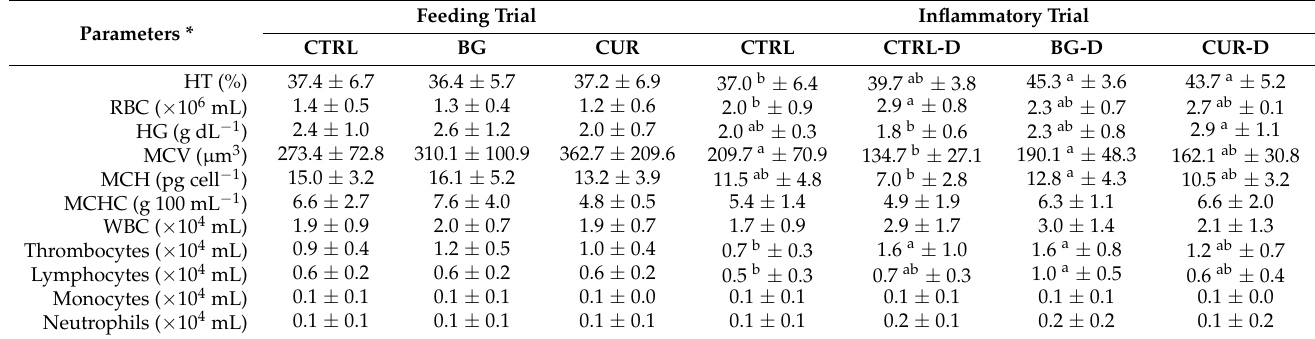
Table 3. Hematological profile of gilthead seabream after the feeding and inflammatory trials ( n = 12). CTRL (control diet), BG (β-glucans diet), CUR (curcumin diet), CTRL-D (control diet + dextran sodium sulphate − DSS), BG-D (β-glucans diet + DSS), CUR-D (curcumin diet + DSS). Values are presented as means ± standard deviation. Different letters mean significant differences among die- tary treatments ( p < 0.05).